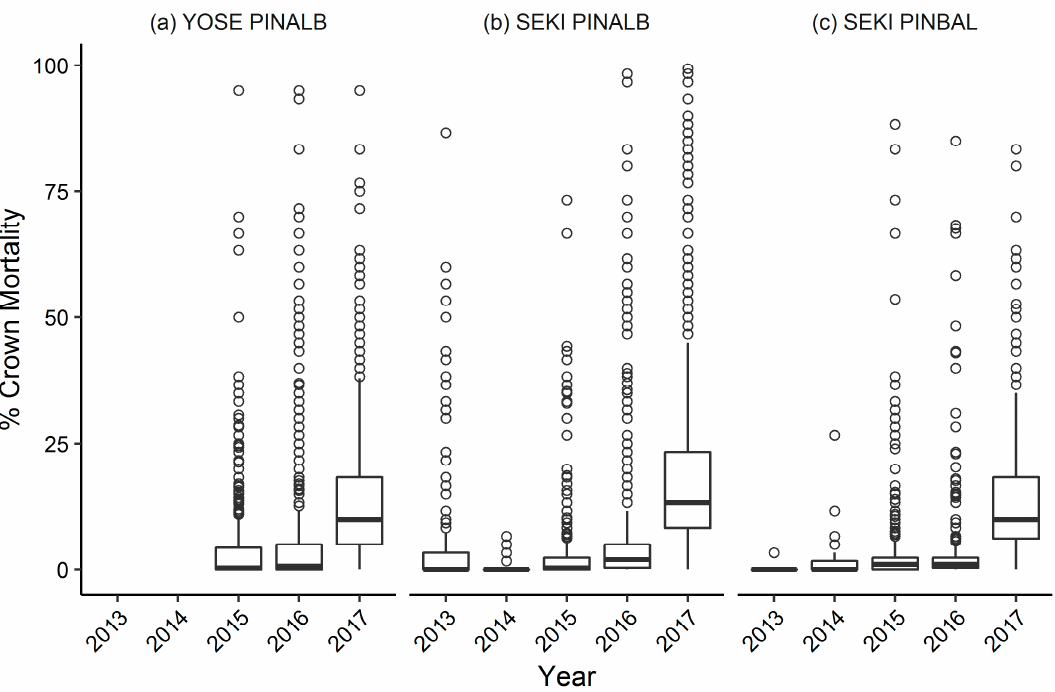
Figure 9. Individual tree percent crown mortality by year in ( a ) Yosemite National Park whitebark pine sample frame (YOSE PINALB), ( b ) Sequoia and Kings Canyon National Parks whitebark pine sample frame (SEKI PINALB), and ( c ) Sequoia and Kings Canyon National Parks foxtail pine sample frame (SEKI PINBAL).